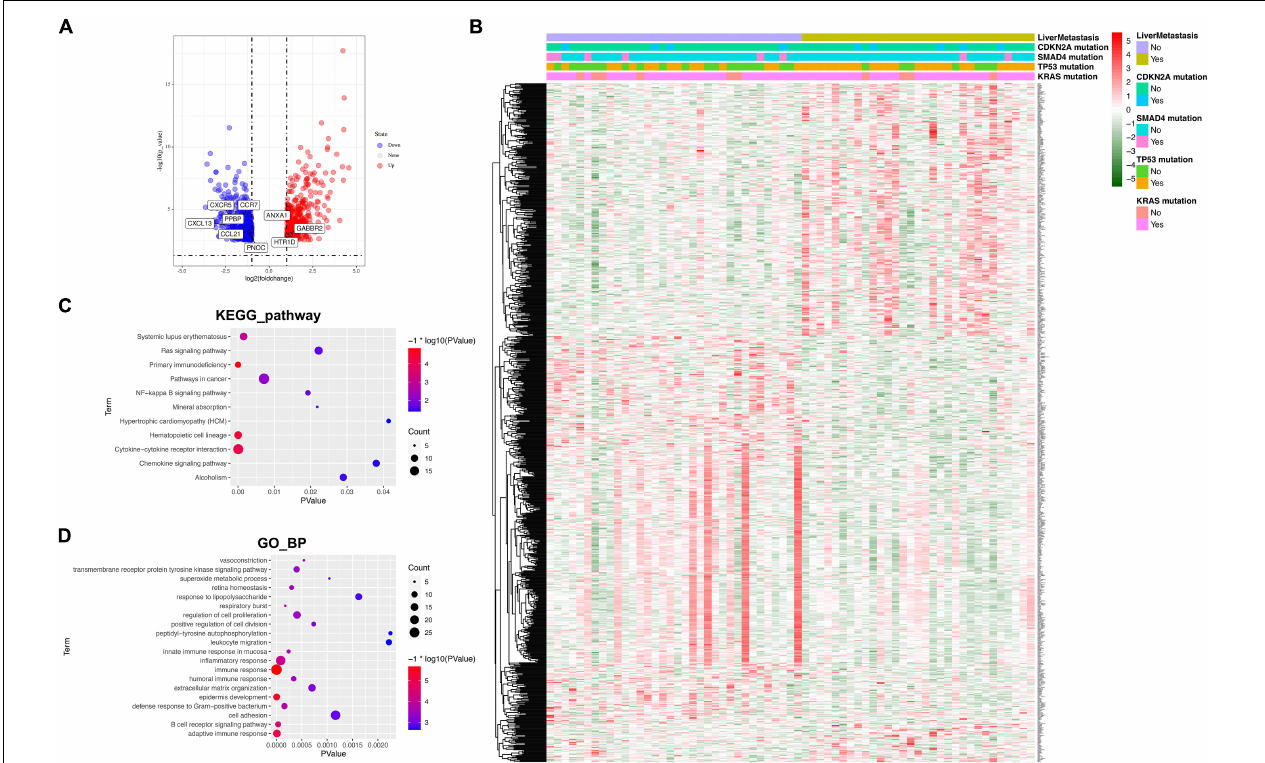
FIGURE 2 | Identification of DGEs and functional analysis. (A) The volcano plot for DGEs comparing recurrence free patients with liver metastasis patients. Eight hundred fifty-seven DGEs, including 493 upregulated genes (red dots) and 364 downregulated genes (blue dots), were identified. (B) Heatmap of DGEs. Mutation status of KRAS, TP53, SMAD4, and CDKN2A was also attached. (C) KEGG pathways analysis of the DGEs. (D) GO analysis for biological processes of the DGEs.